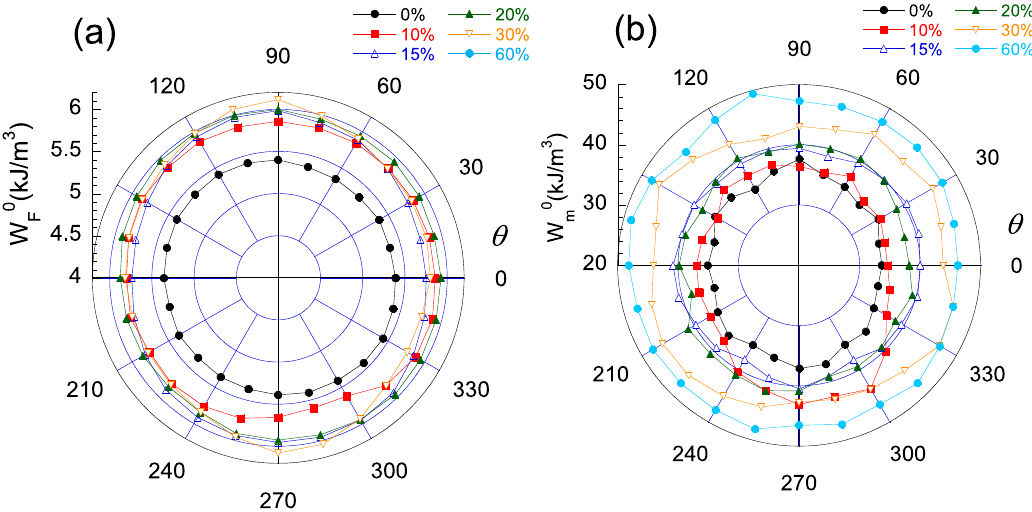
Figure 10. The θ -dependence of ( a ) W F0 and ( b ) W m0 obtained at different levels of rolling reduction.